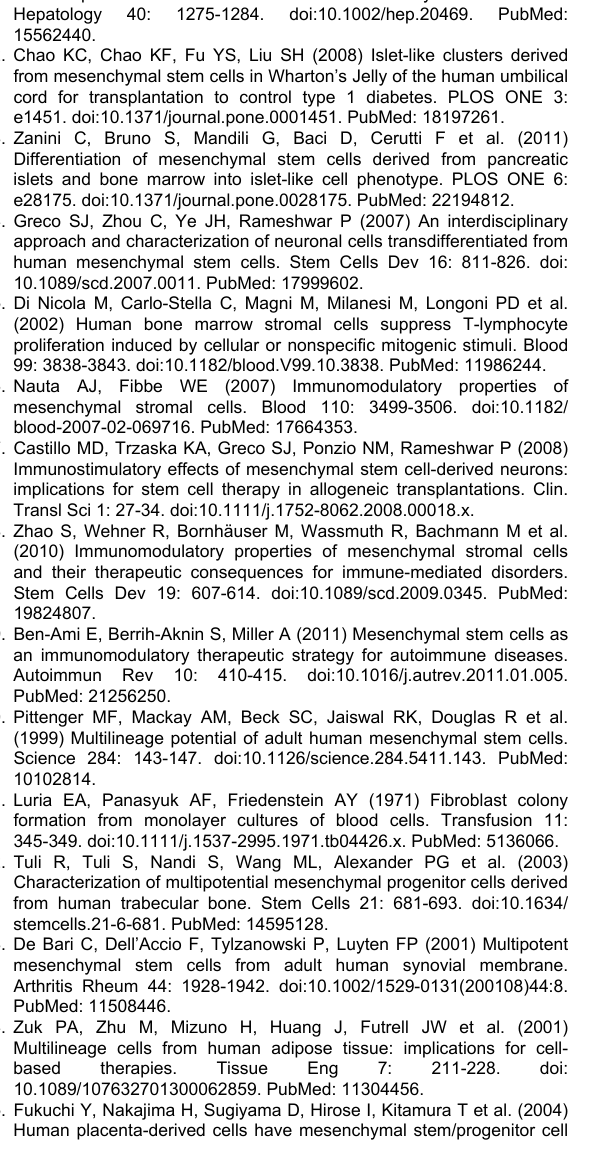
Table S3. Comparison of differentiation capacity of mouse and human-derived MSCs. (DOCX) Table S4. Comparison of cytokine and chemokine